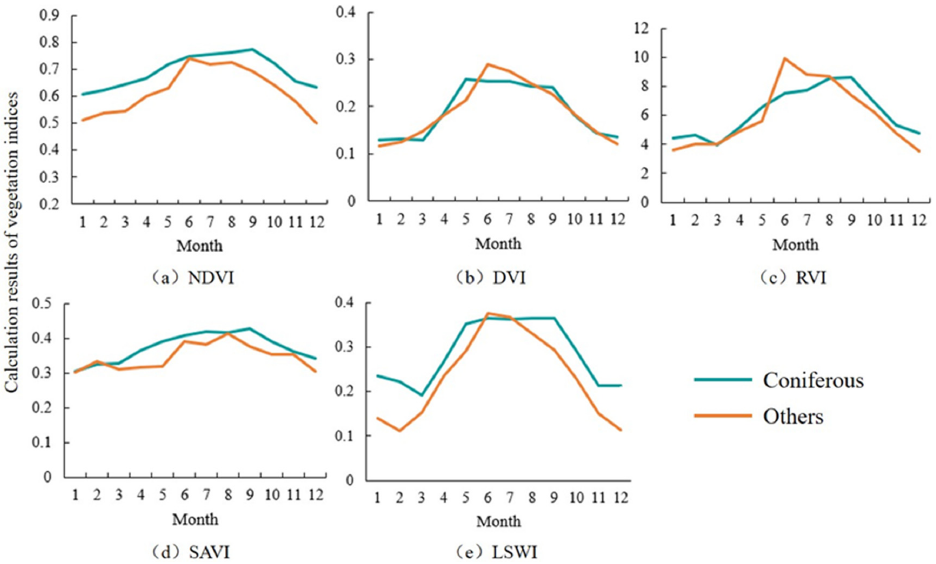
Figure 4. Comparison of five vegetation indices time-series change curves of coniferous forest and other forest types.